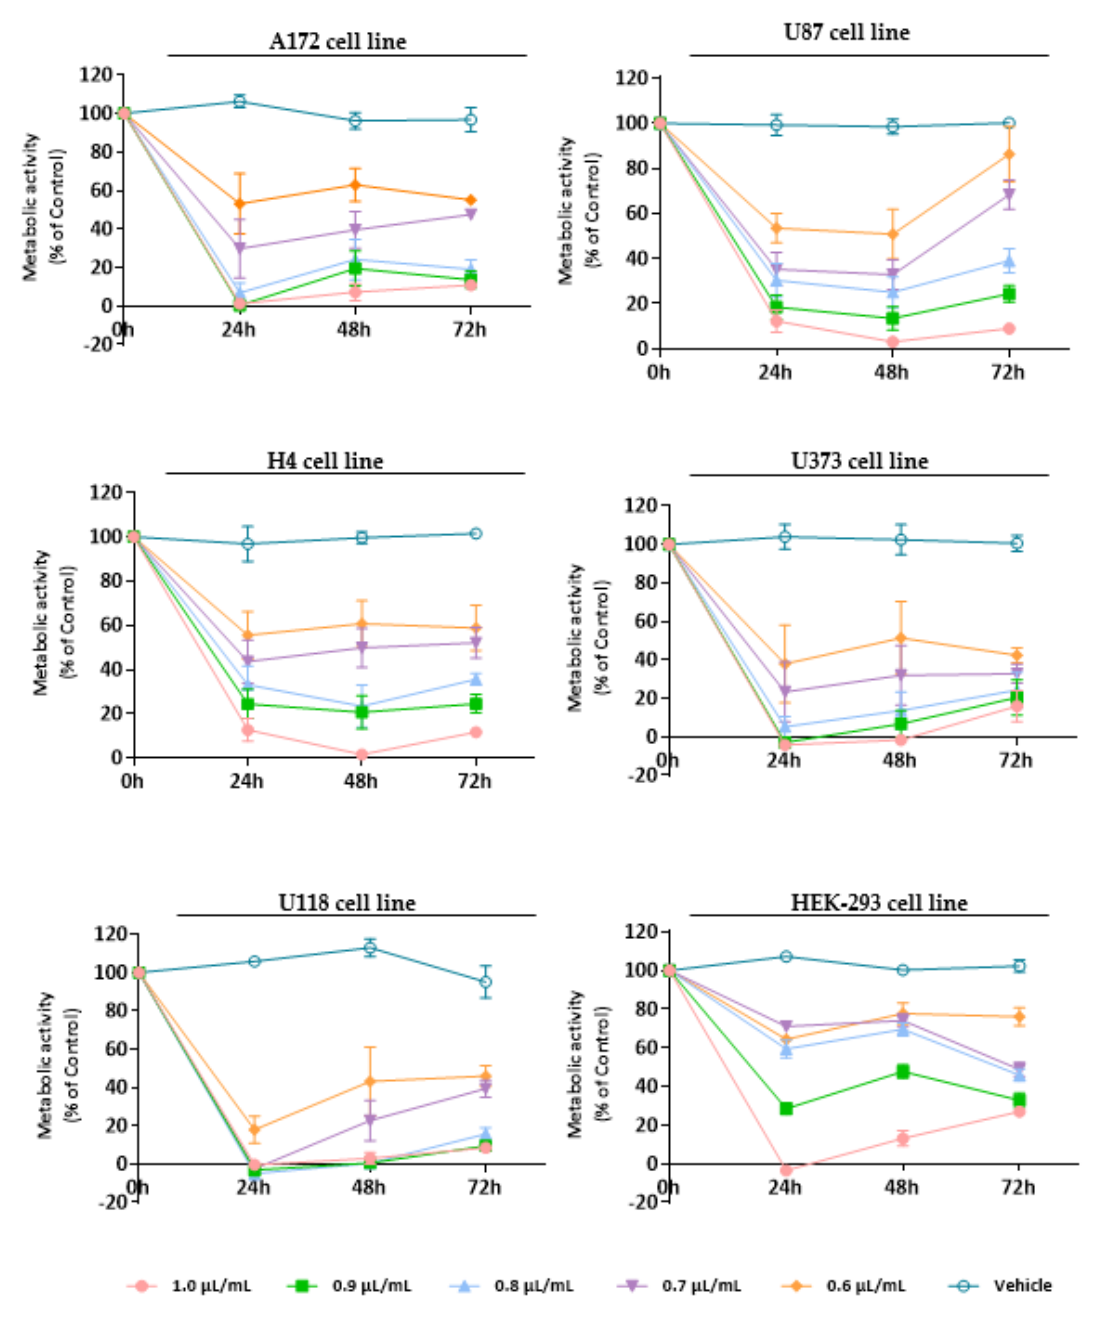
Figure 2. Cytotoxic effect of L. pedunculata EO against GB cells (A172, U87, H4, U373, and U118 cell lines) and non-tumoral cells (HEK-293 cell line). Cells were treated either with L. pedunculata EO (1.0, 0.9, 0.8, 0.7, and 0.6 µL/mL) or with the vehicle control (DMSO) for 24, 48, and 72 h. Cell viability (metabolic activity) was expressed as percentage of control (untreated cells). Results were presented as mean ±